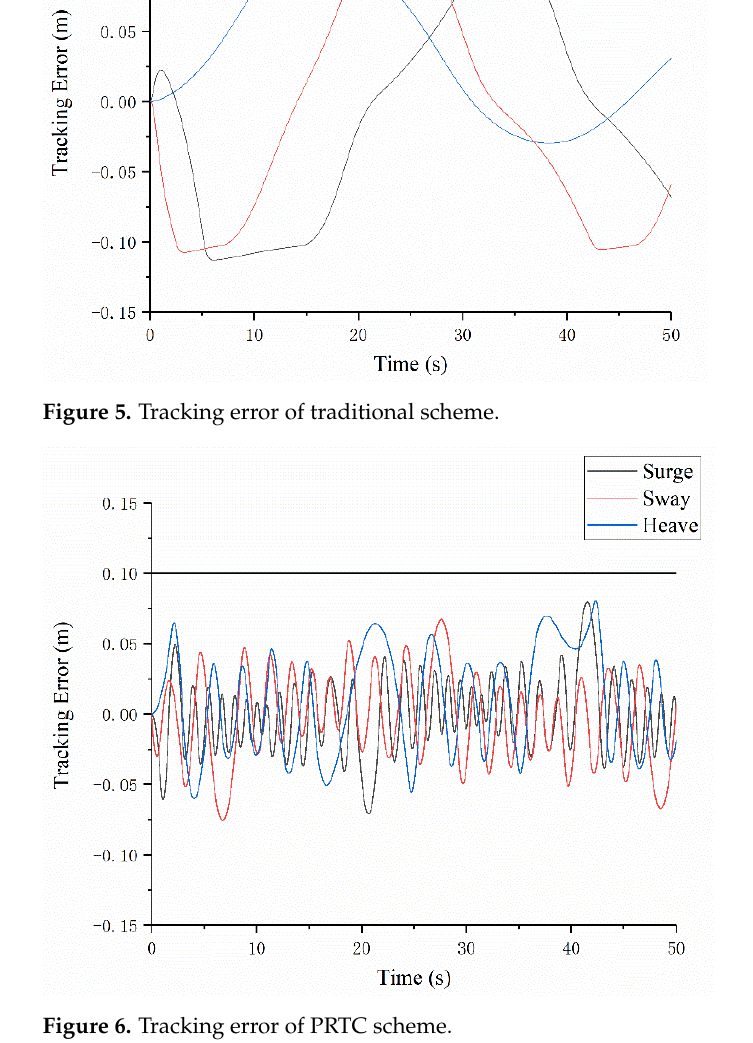
Figure 6. Tracking error of PRTC scheme.